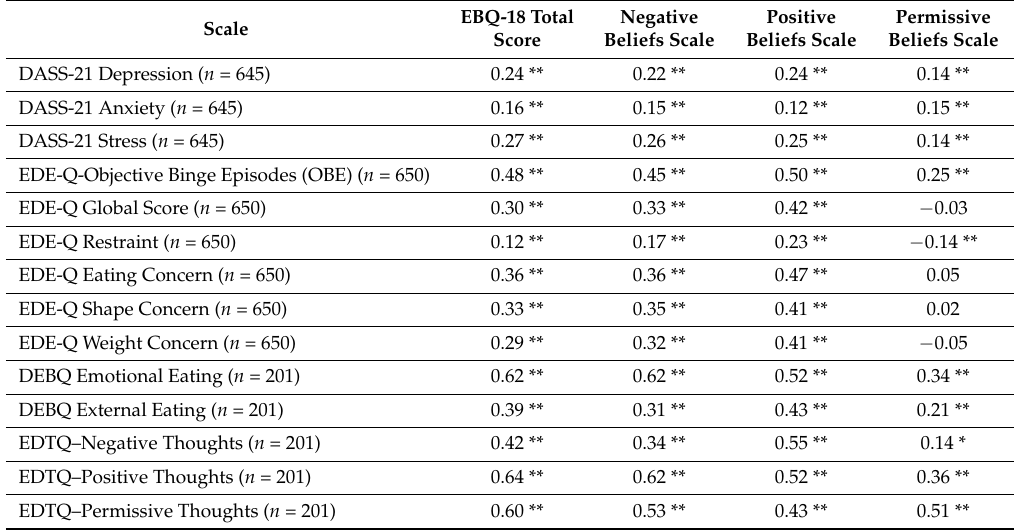
Table 4. Correlations between EBQ-18 Scores and other symptom and cognitive measures. Scale